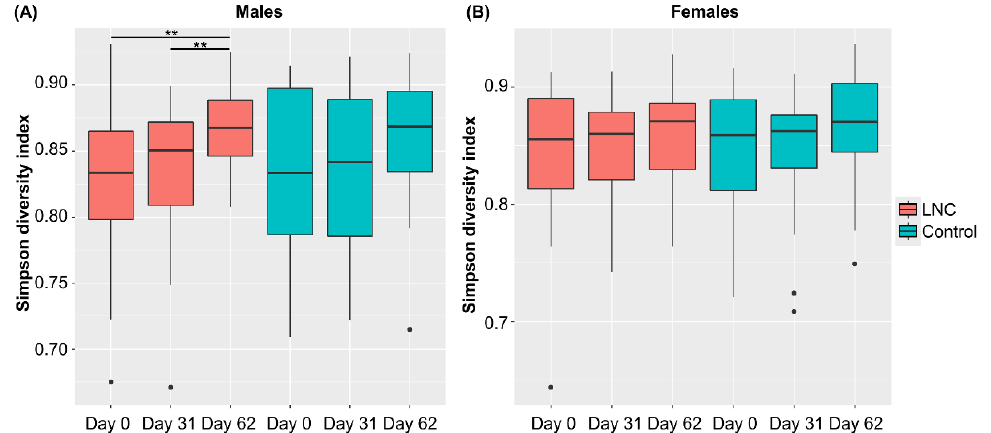
Figure 3. Changes in the diversity of intestinal microbiota following ingestion of SONOMONO NATTO POWDER CAPSULES TM . Box plot of α -diversity calculated using the Simpson diversity index. Each dot represents outliers. ( A ) Males, ( B ) females. Significant increase in α -diversity was observed between samples collected from males in the LNC (lyophilized natto capsules) group on Day 0 and 62 and on Day 31 and 62. ** p < 0.01.